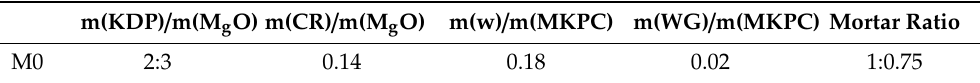
Table 2. M0 mix ratio of blank